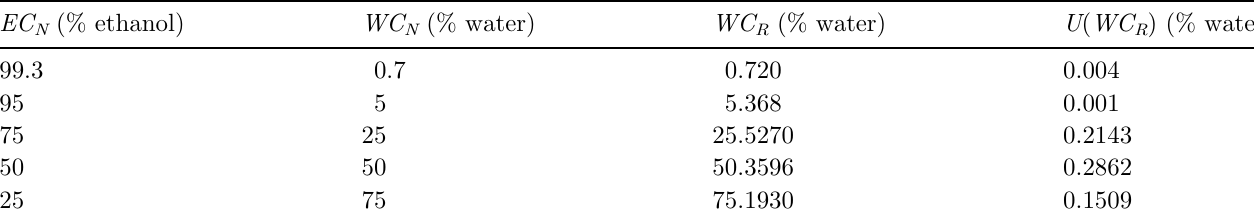
Table 1. Concentrations and expanded uncertainties of the samples.